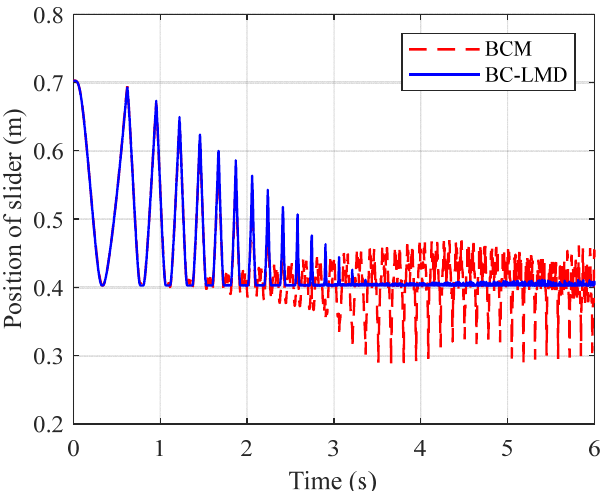
The bounds obtained by the BC-LMD present a tighter envelope compared with the BCM.